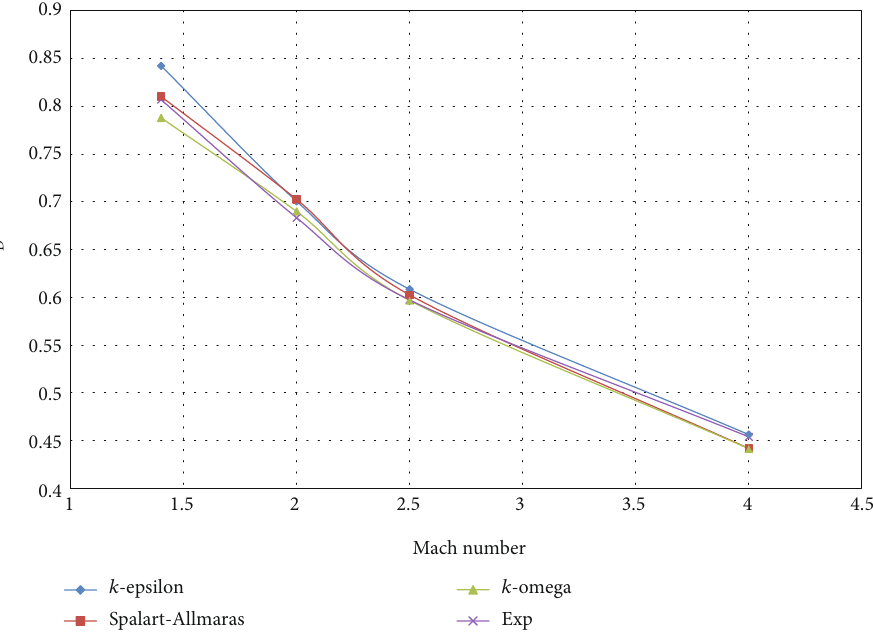
Figure 8: Drag coe ffi cient versus Mach number at 6 ° AoA.